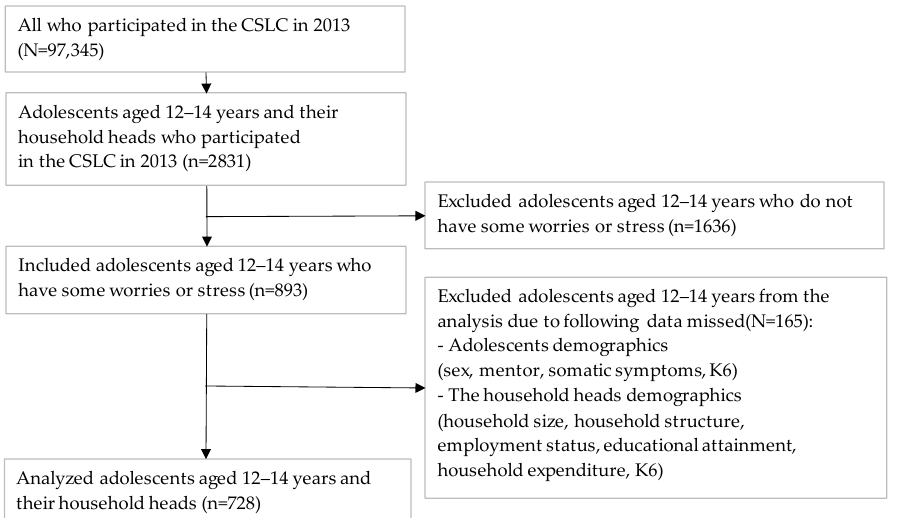
Figure 2. Flowchart of participant selection process.CSLC: the Comprehensive Survey of Living Conditions; K6: six-item Kessler Psychological Distress Scale.